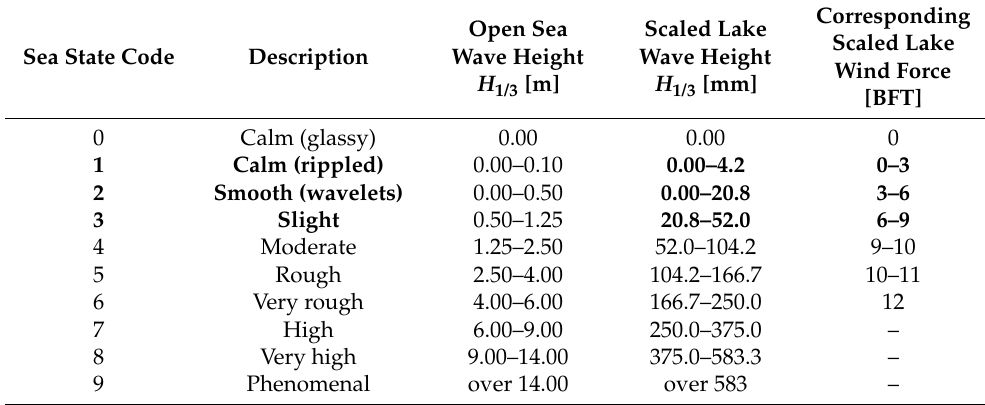
Table 5. Sea state codes and corresponding scaled lake wave heights and wind forces.